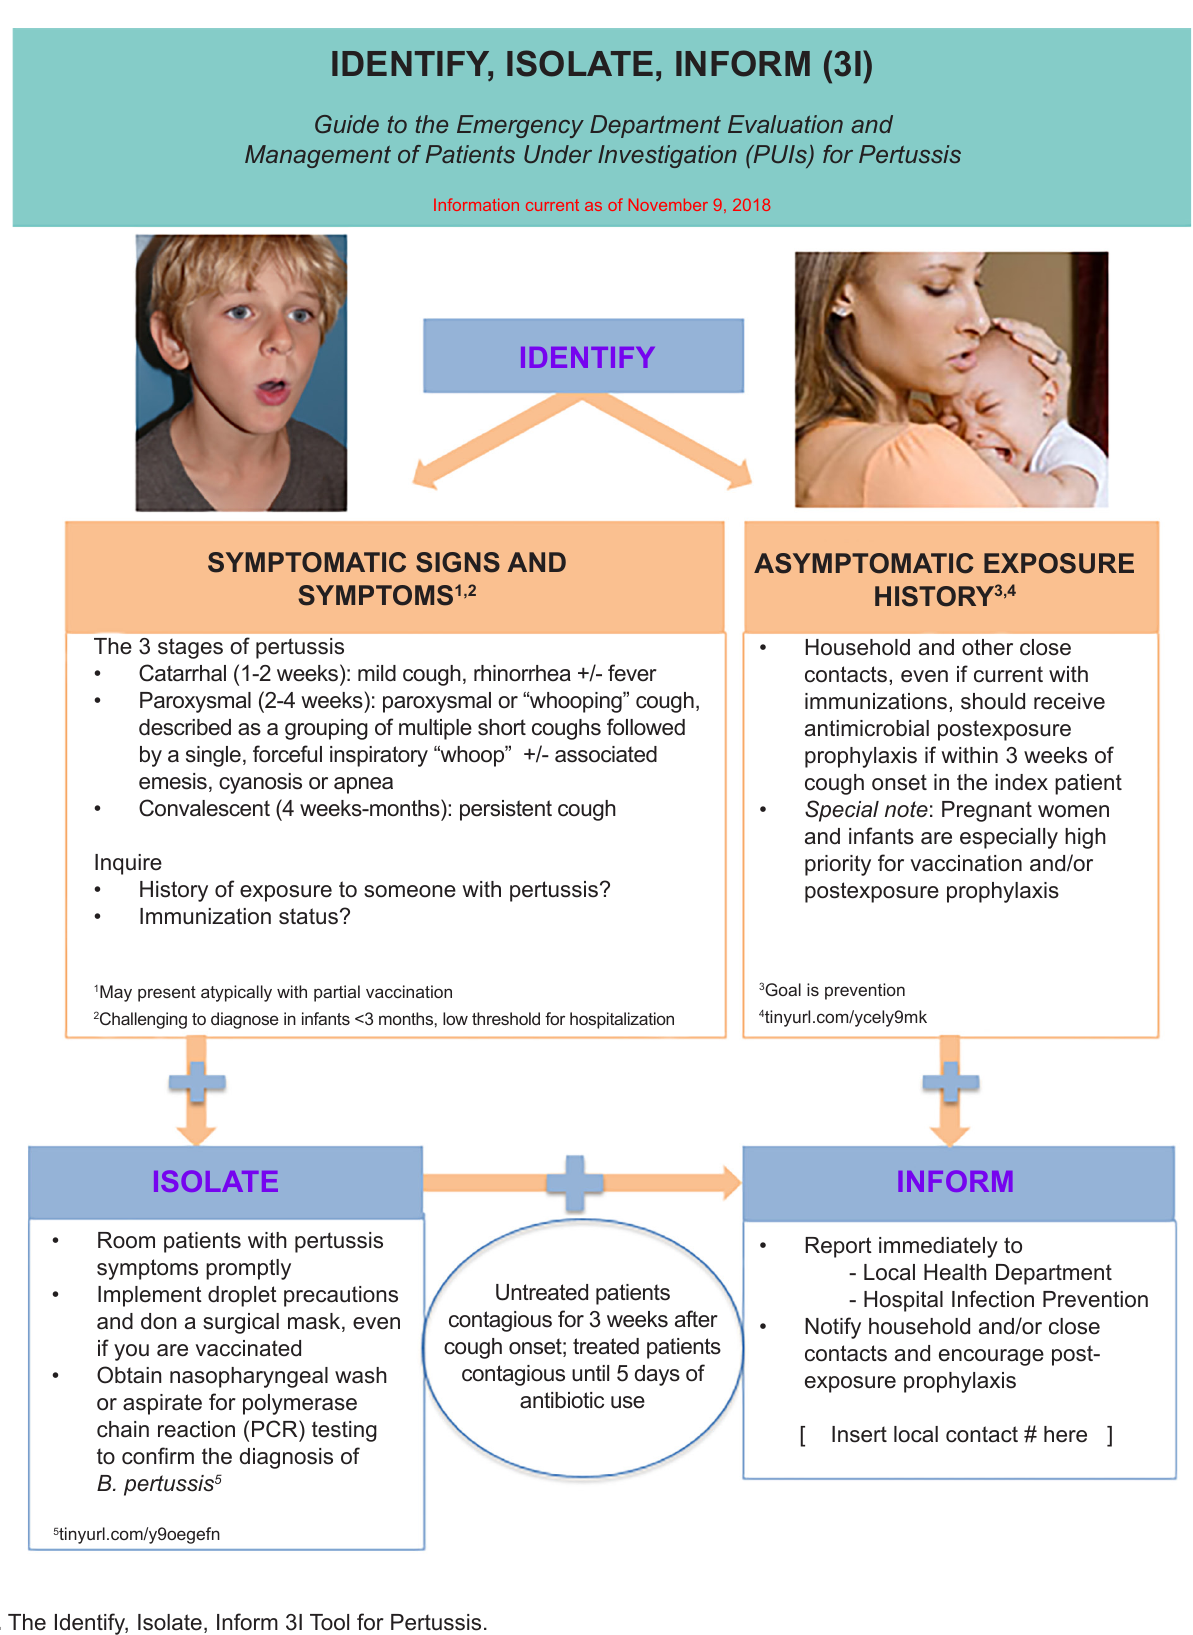
Figure. The Identify, Isolate, Inform 3I Tool for Pertussis. The Identify, Isolate, Inform 3I Tool was conceived by Dr. Kristi L. Koenig, County of San Diego EMS Medical Director & Professor Emerita, UC